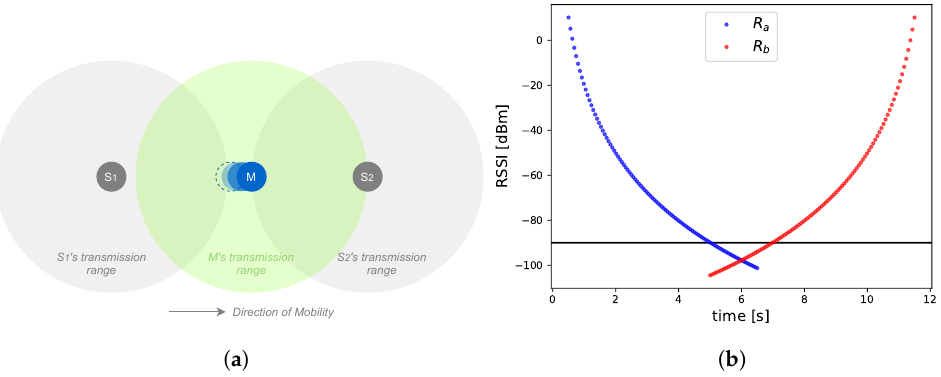
Figure 5. The illustration of the scenario considered for the analytical evaluation—( a ) mobile node M moves from vicinity of its current parent (S1) to the future parent (S2); ( b ) expected RSSI values with respect to the lower threshold of RSSI when M starts moving from vicinity of AP a to AP b